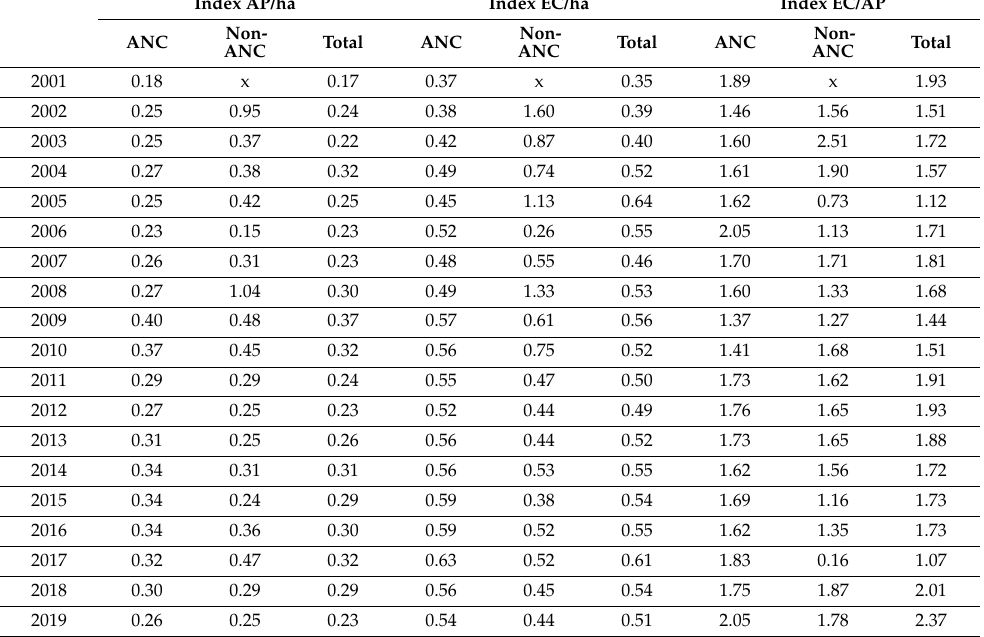
Table 2. Performance (AP) and direct energy consumption (EC) in organic vs. conventional farming.